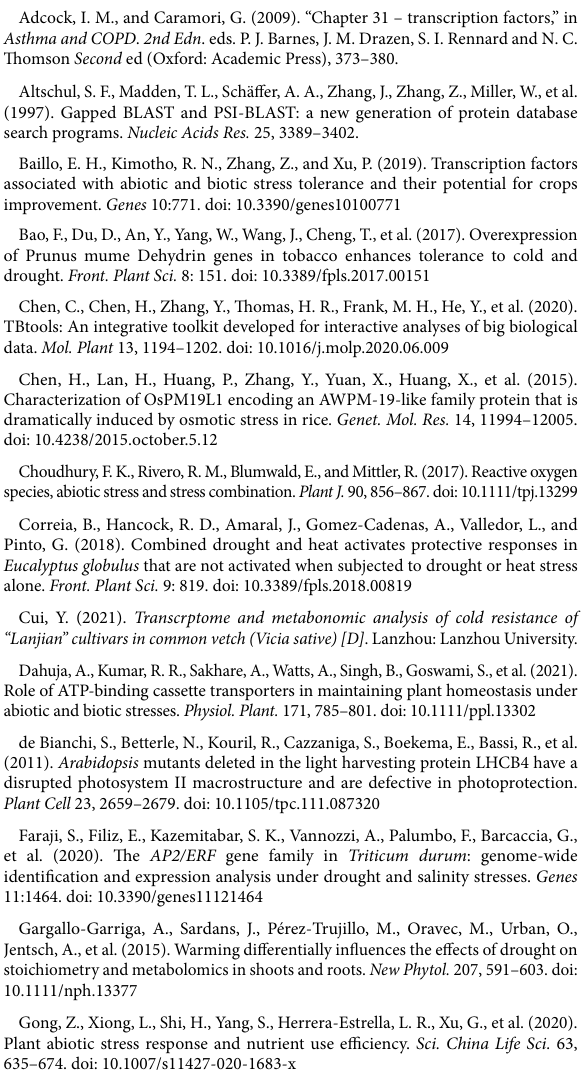
SUPPLEMENTARY FIGURE S1 Characteristics of novel transcripts. (A) The expression pattern distribution of novel transcripts. (B) The expression level of novel transcripts under cold-drought combined stress in leaves and roots. SUPPLEMENTARY FIGURE S2 Validation of the expression profiles (log2-fold change) of 15 selected DEGs from leaves and roots using qRT–PCR. The green bars represent qRT-PCR-expressed leaves (left y-axis), and the blue trend lines represent the FPKM value changes of the DEGs (right y-axis). SUPPLEMENTARY FIGURE S3 The expression (Log2-fold change) correlation of 15 DEGs based on RNA-Seq via qRT-PCR. SUPPLEMENTARY FIGURE S4 The expression profile of 63 co-induced transcription factors in leaves and roots,